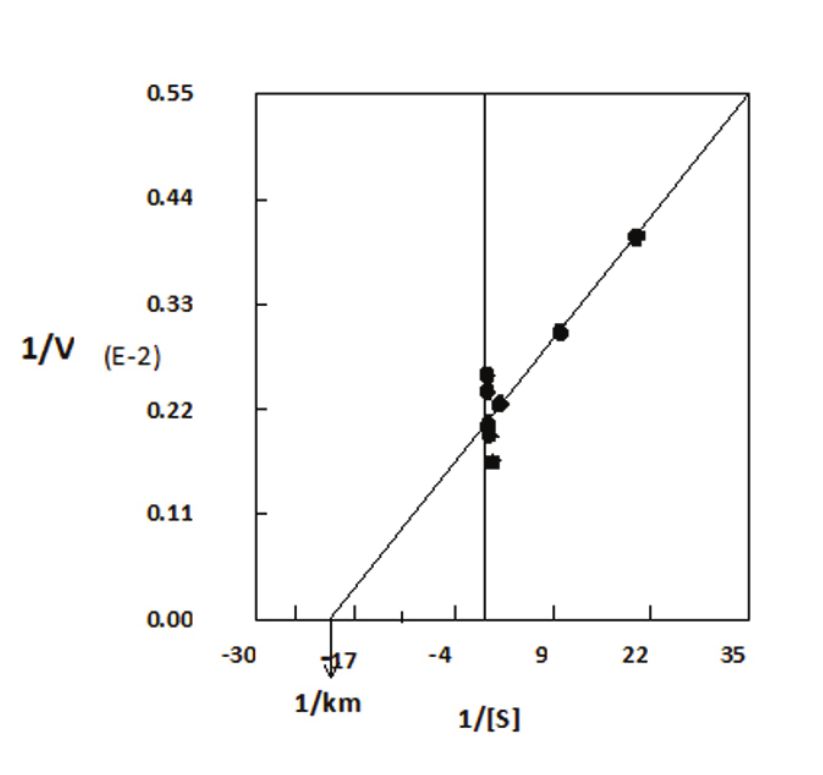
Figure 2. The Lineweaver-Burk plot, representing reciprocal of initial enzyme velocity versus AcSCh determination. K 0.068 mM; V = 651 µmol/min/mg protein. concentration for K m m max